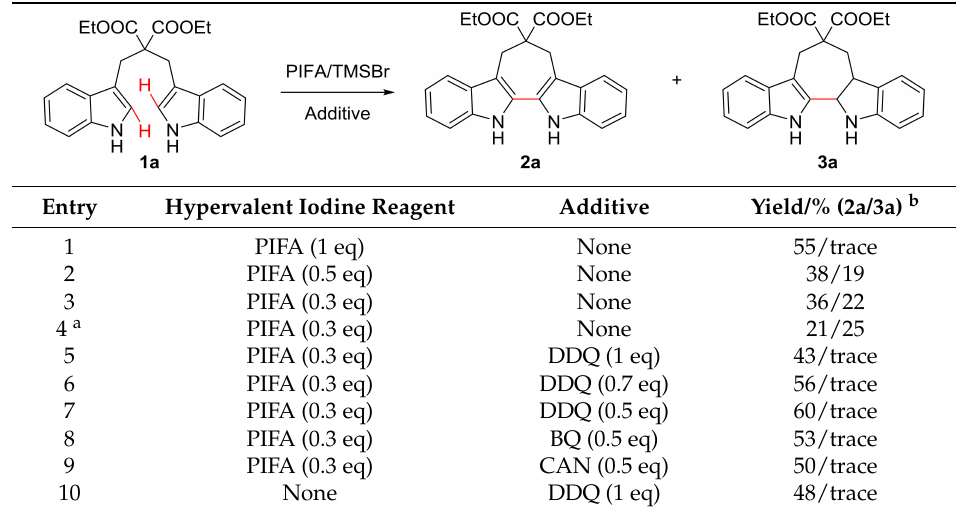
Table 1. Optimization of PIFA mediated oxidative cyclization/ aromatization.